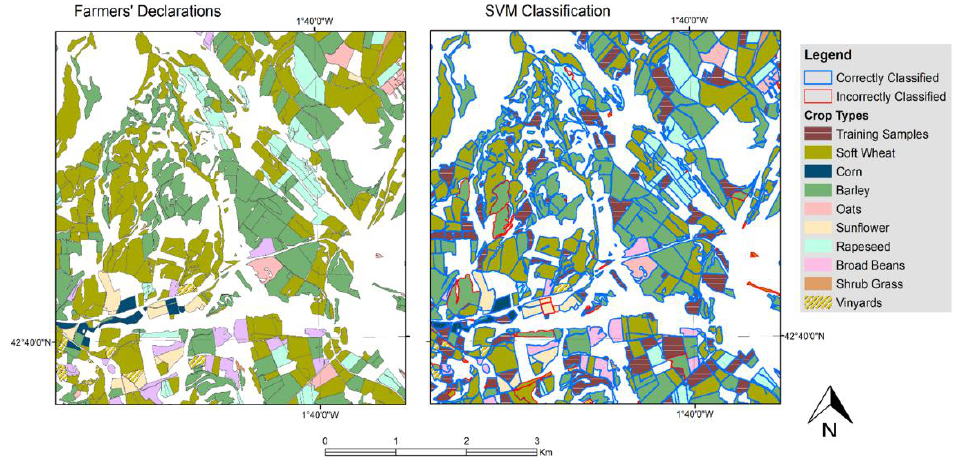
Figure 5. Farmers’ declarations and quadratic SVM classification at the lowest nomenclature level (crop type). Only a clipped part of the study site is shown, with correctly and incorrectly classified parcels also